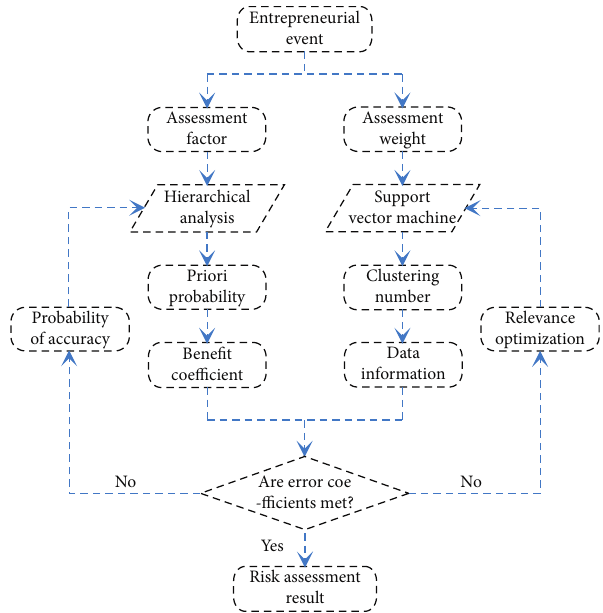
Figure 3: Flowchart of risk assessment algorithm for college student entrepreneurship based on big data